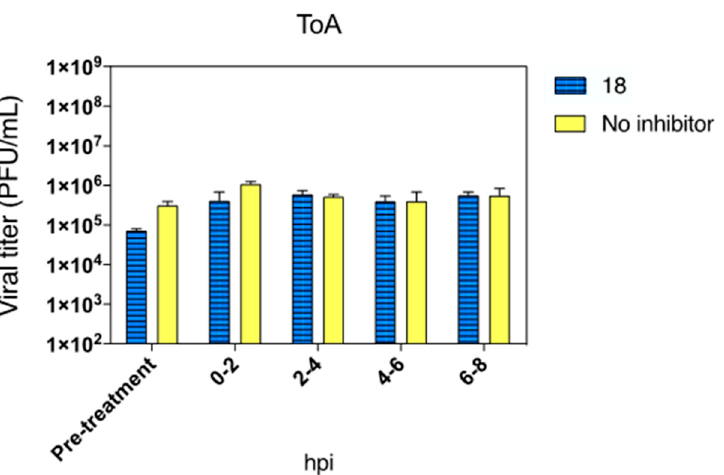
Figure 9. Pre-treatment and time course experiment. Vero-76 cells were pre-treated with compound 18e (20 μ M) for 2 h. After this period, the monolayers were infected with CVB5 (m.o.i. = 1). After infection period for time of addition condition, the compound 18e (20 μ M) was added at the indicated times. Viral yields were then determined by plaque assay. Dark columns, the viral yield for control cells; grey columns; viral yield for cells treated with 18e .